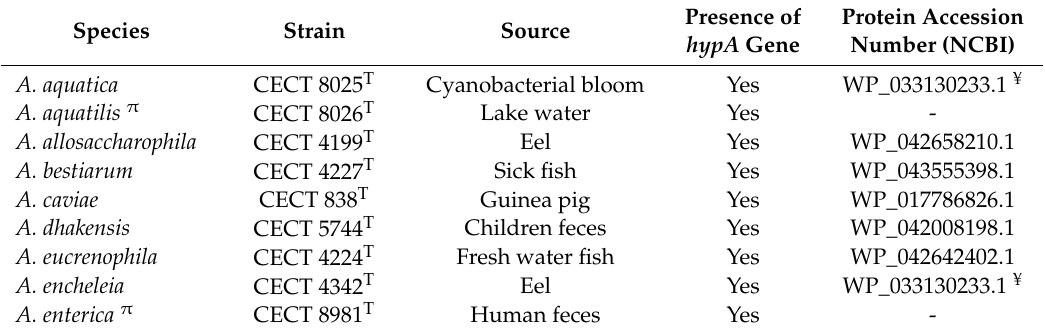
Table 2. Presence / absence of hypA gene in the genomes of 36 Aeromonas species described until